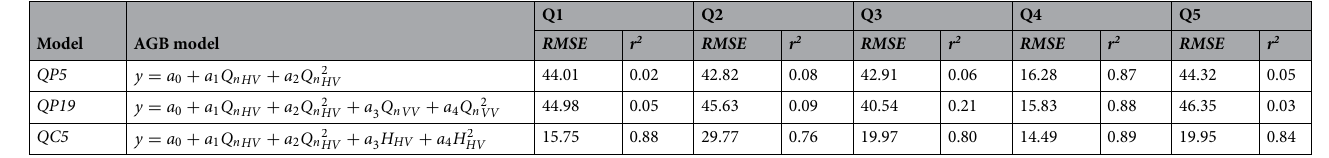
Table 4. Summary of TomoSAR power metric (Q) and integrated Q & TFH AGB